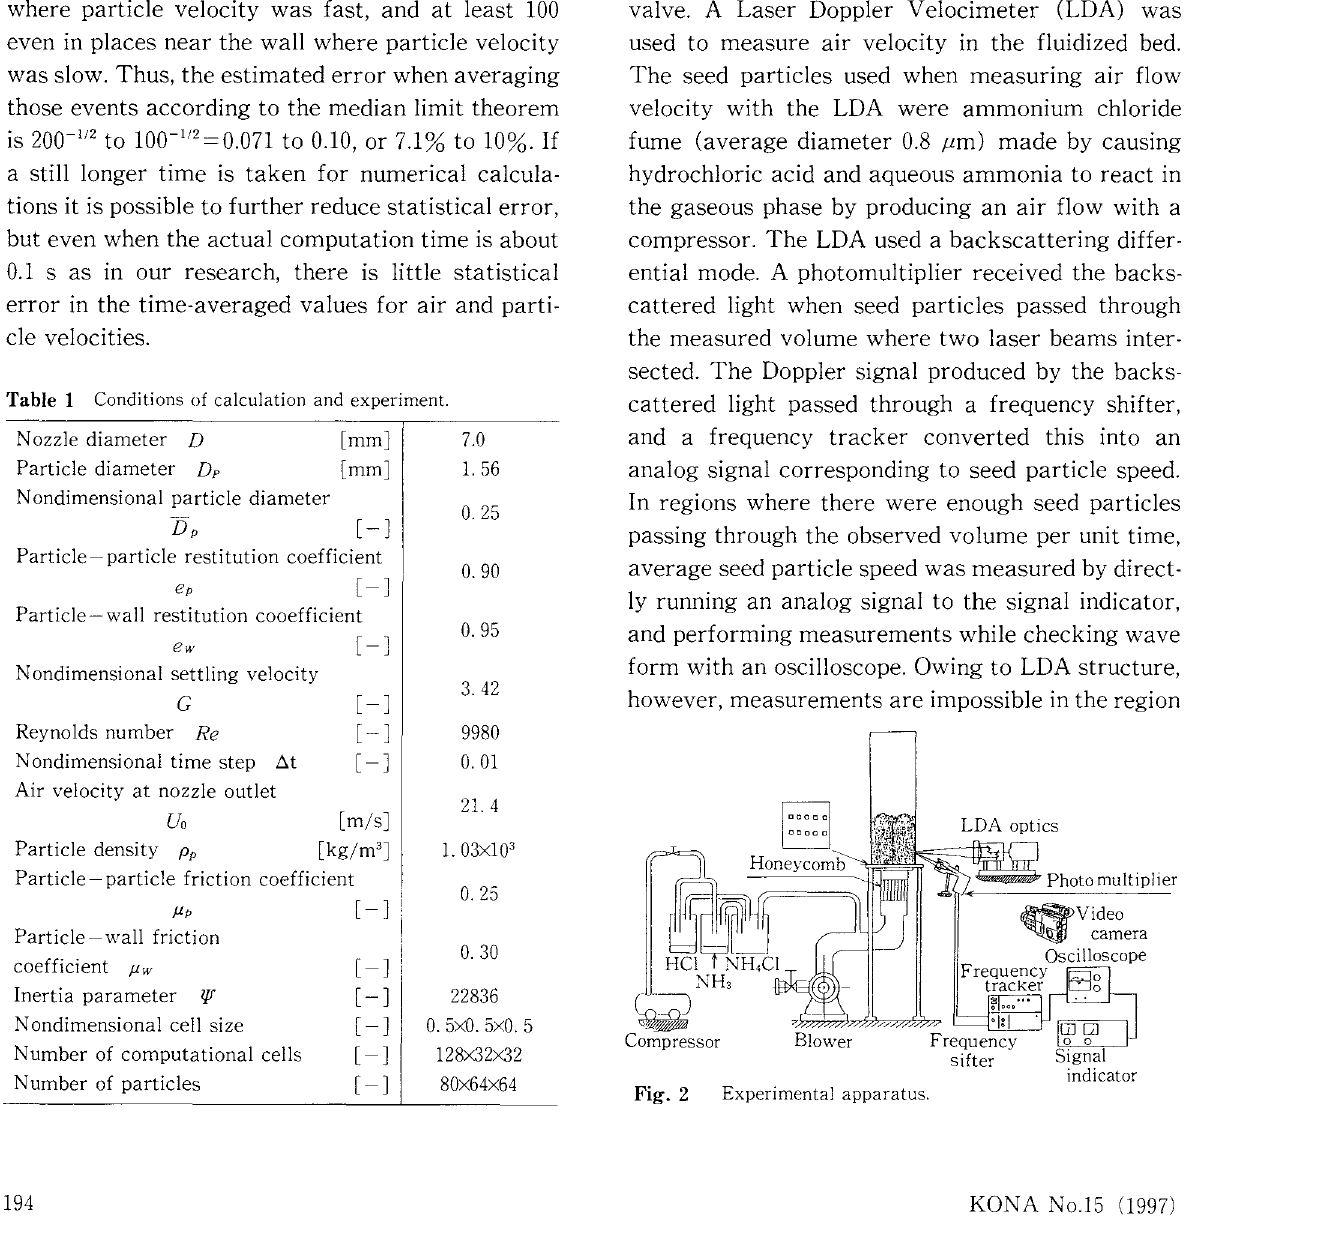
Table 1 Conditions of calculation and